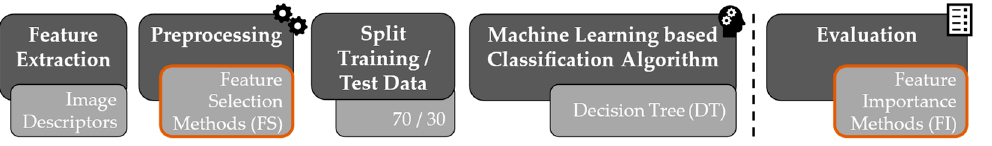
Figure 9. Schematic representation of the individual components of the classification chain used. The methods highlighted in orange are used to identify in fl uential image features.